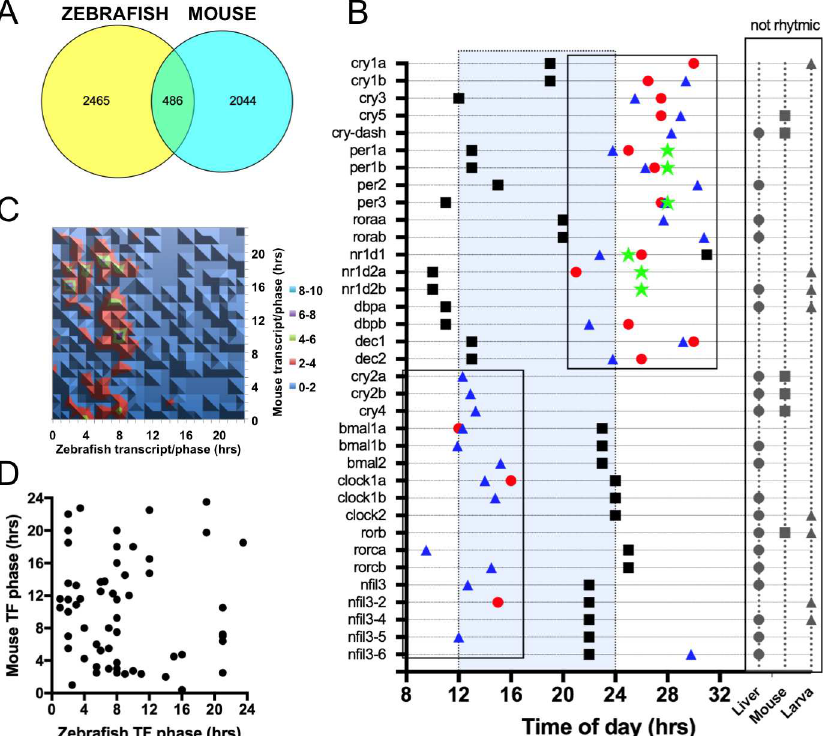
Fig 3. Comparison of Zebrafish and mouse liver rhythmic genes. (A) Venn diagramof the rhythmic transcripts identified in Zebrafish and mouse livers. The Zebrafish liver data were converted into putative mouse ENSEMBL orthologs(2951 uniquegenes) and comparedwith the Hugheset al. dataset [10](1hr resolution for 2d in DD from CircaDB)(2530 UniqueENSEMBL genes). (B) Expression phase for clock genes in zebrafish, mouse and human. Red circle: Zebrafish liver; Blue triangle: Zebrafish larva; Black square: Mouse liver; Green star: Human hair follicle cells [51]. Grey symbols correspondto arrhythmic genes. (C). Contourplot of the 486 common cycling genes betweenthe Zebrafish and mouse liver time courses. Color code in legendrepresents the number of genesat each phaseintersection. (D) Scatter plot of the phaseof all cycling TFs genesbetweenthe mouse and Zebrafish time